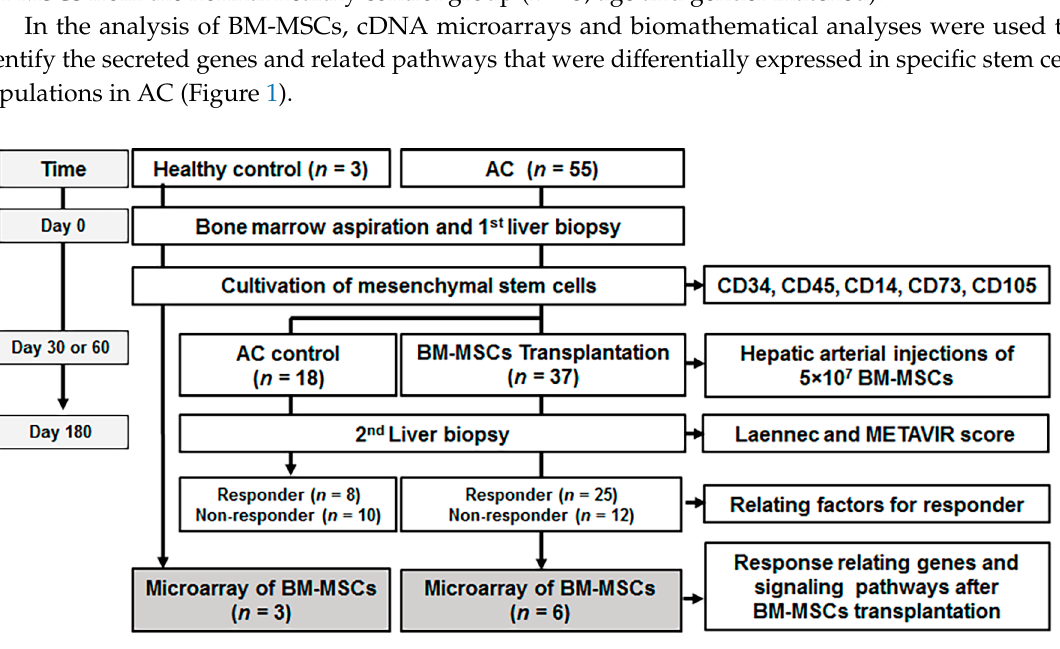
Figure 1. Study design. AC, alcoholic cirrhosis; BM-MSCs, bone marrow-derived mesenchymal stem cells; n ,